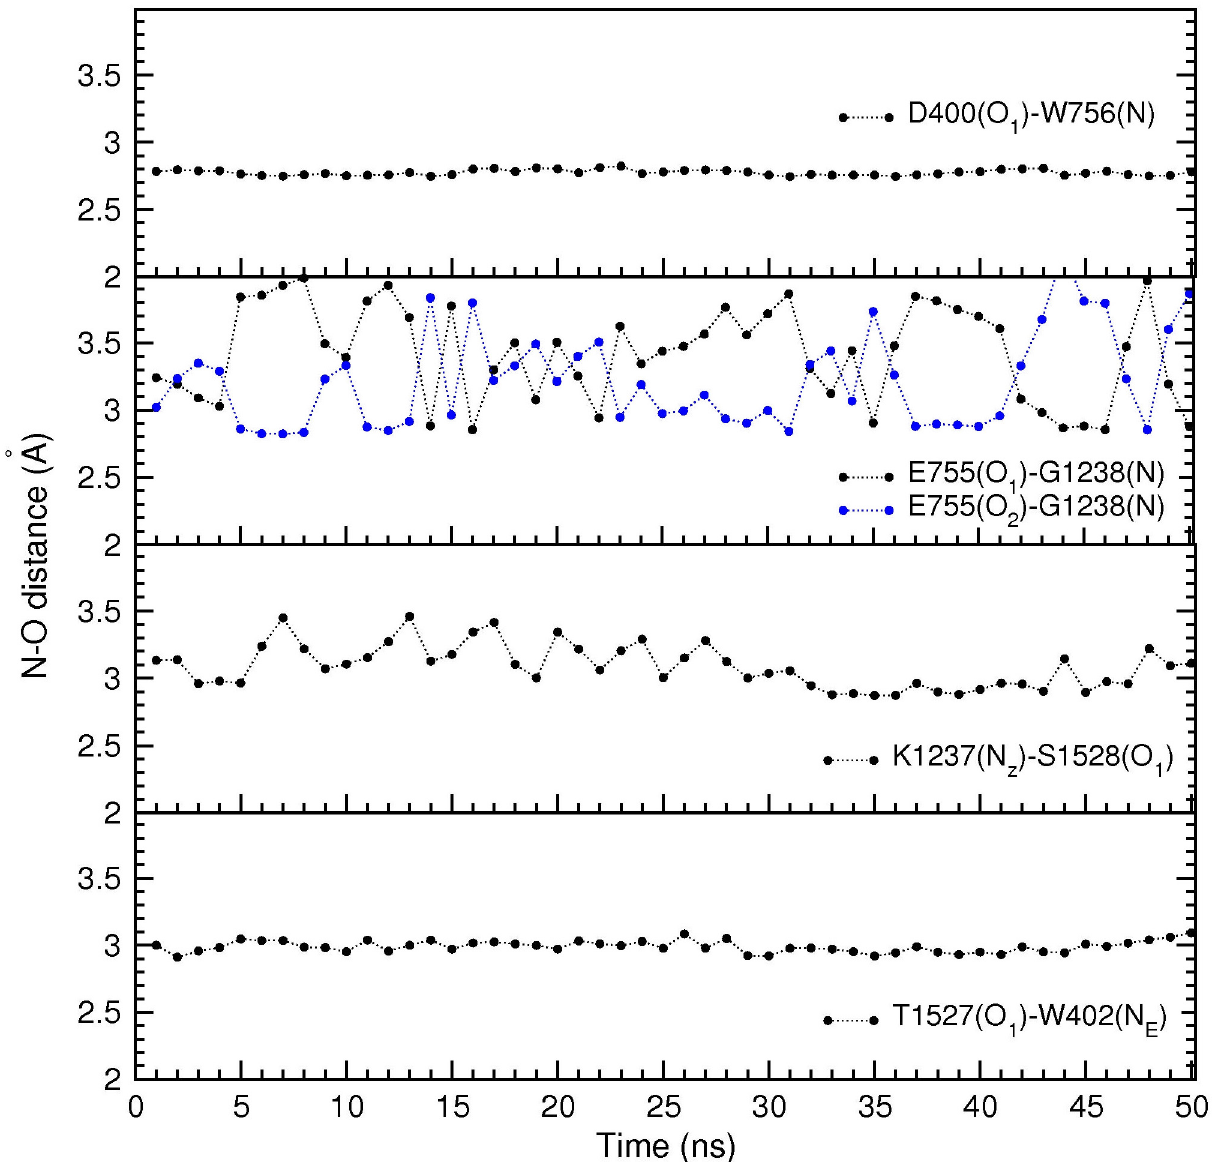
Fig 4. Time series of the N – O distances between the linked residues in the SF. The results are obtained from 50 ns of MD simulations, averaged over 1 ns blocks. The flipping of the side chain observed in E755 does not happen in D400 because the second oxygen in the side chain is involved in the coordination of the Na + ion in the